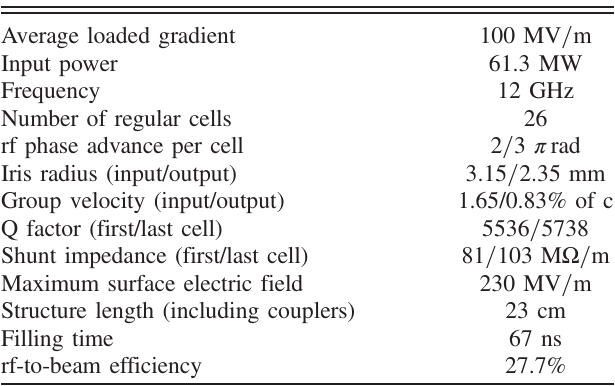
TABLE II. TD26CC structure parameters with CLIC main beam parameters and 100 MV = m of accelerating gradient (3 TeV CLIC baseline) [23].